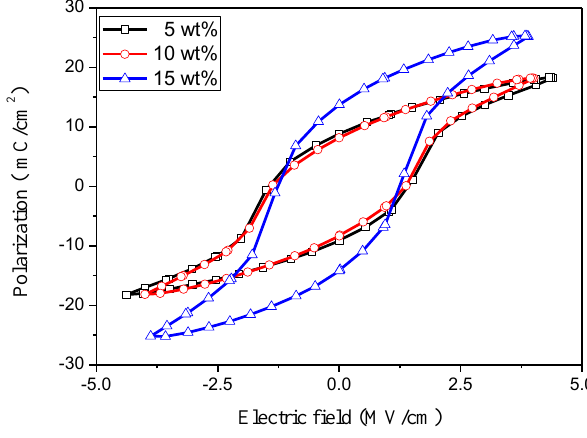
Figure 7. The remnant polarization of PVDF films with different PVDF concentrations, which are annealed at 80 °C for 2 h.